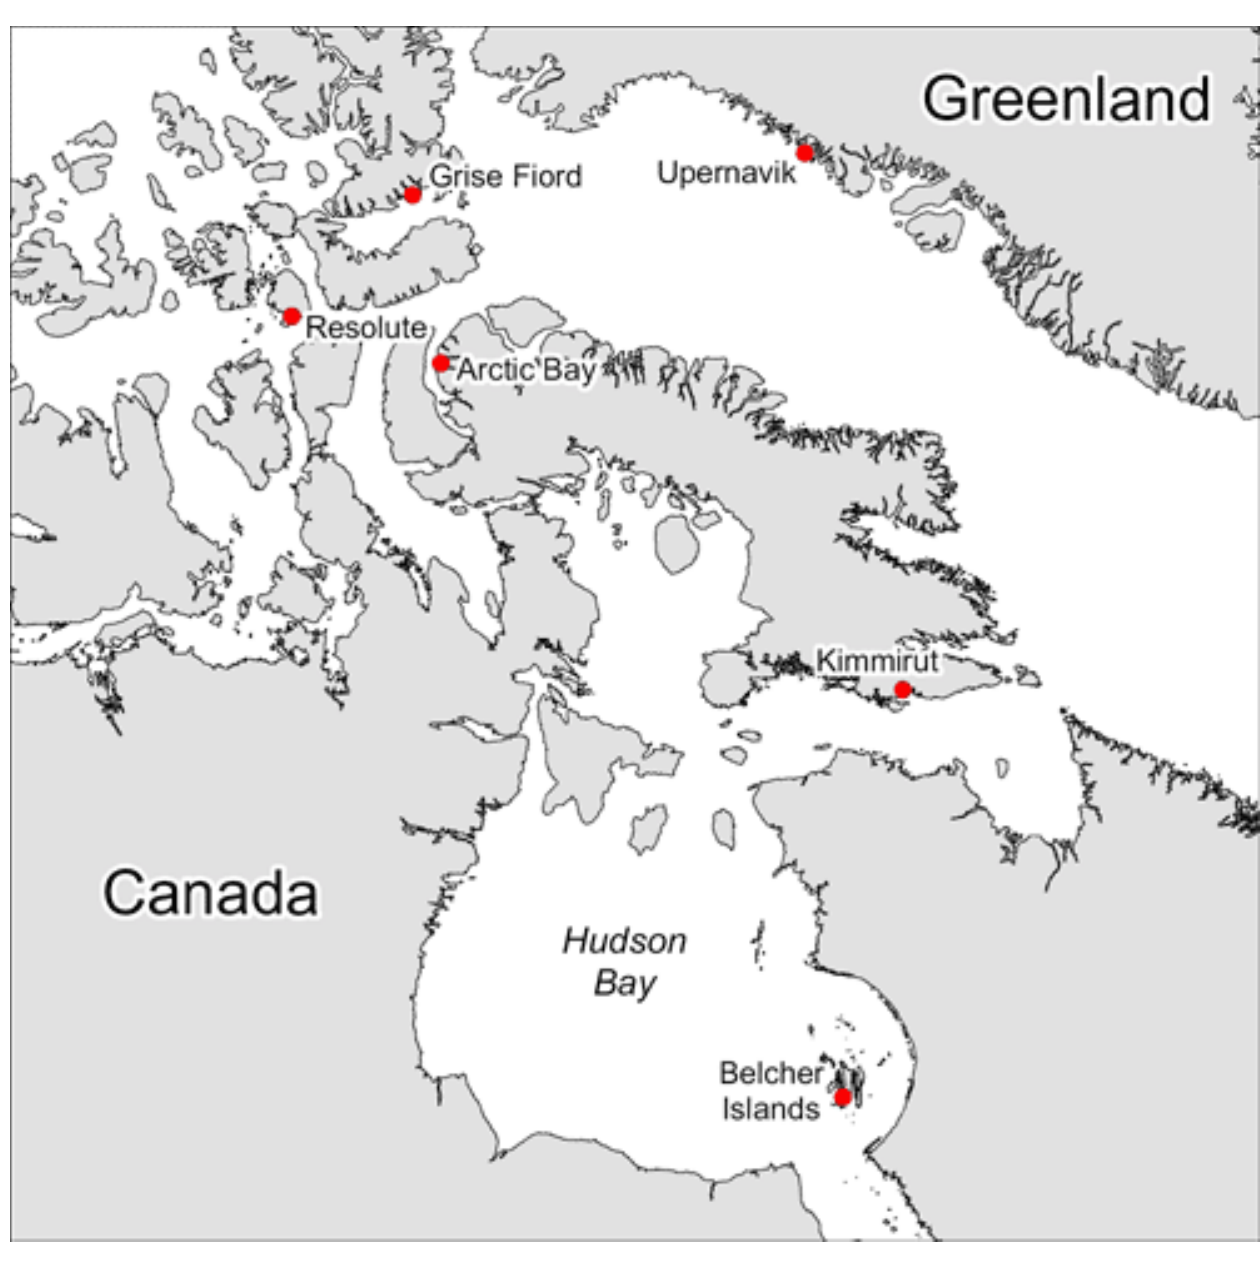
Fig. 1 . A map illustrating locations of